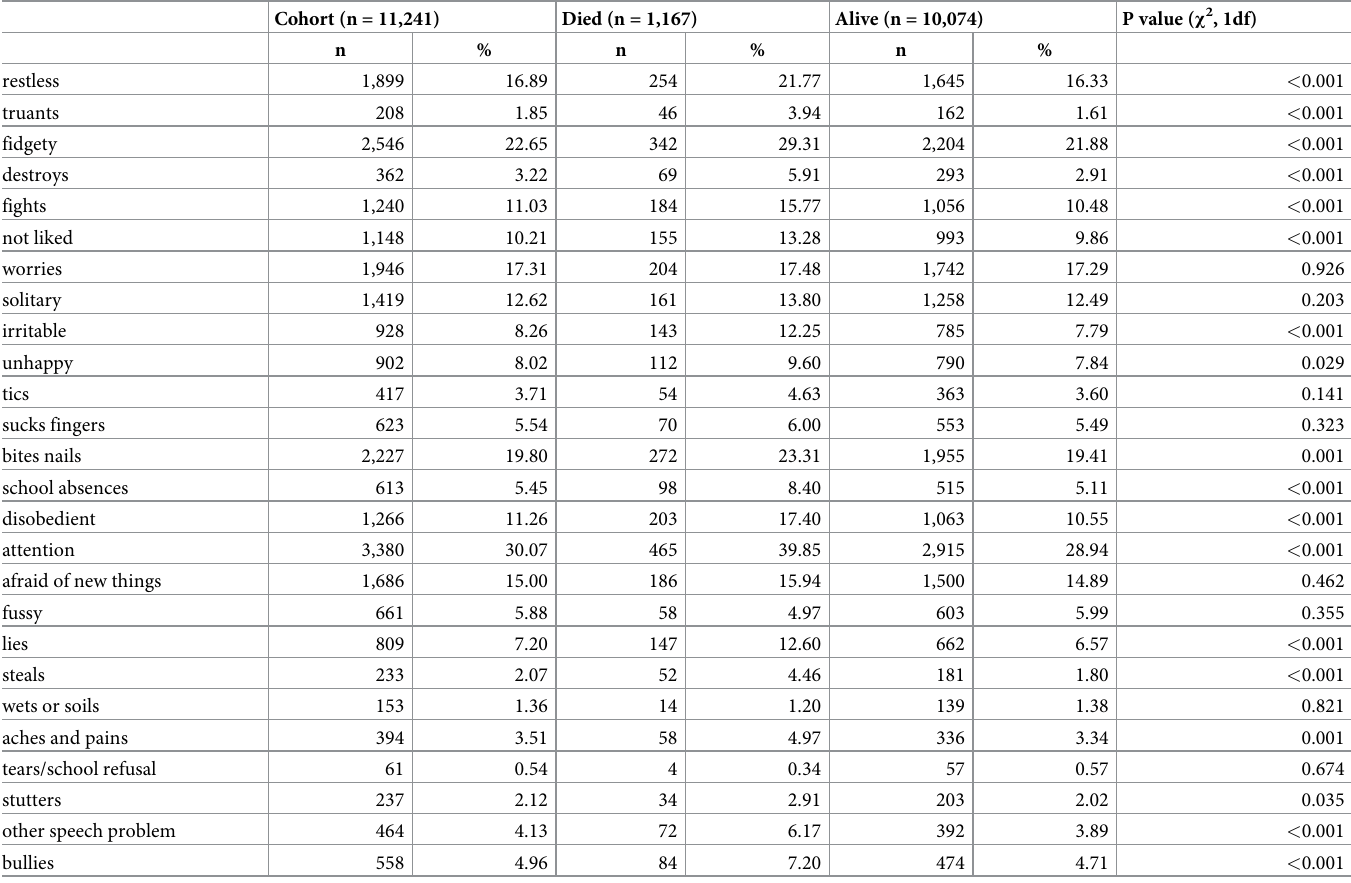
Table 1. Frequency of neurodevelopmental markers reported on Rutter B scale by vital status.